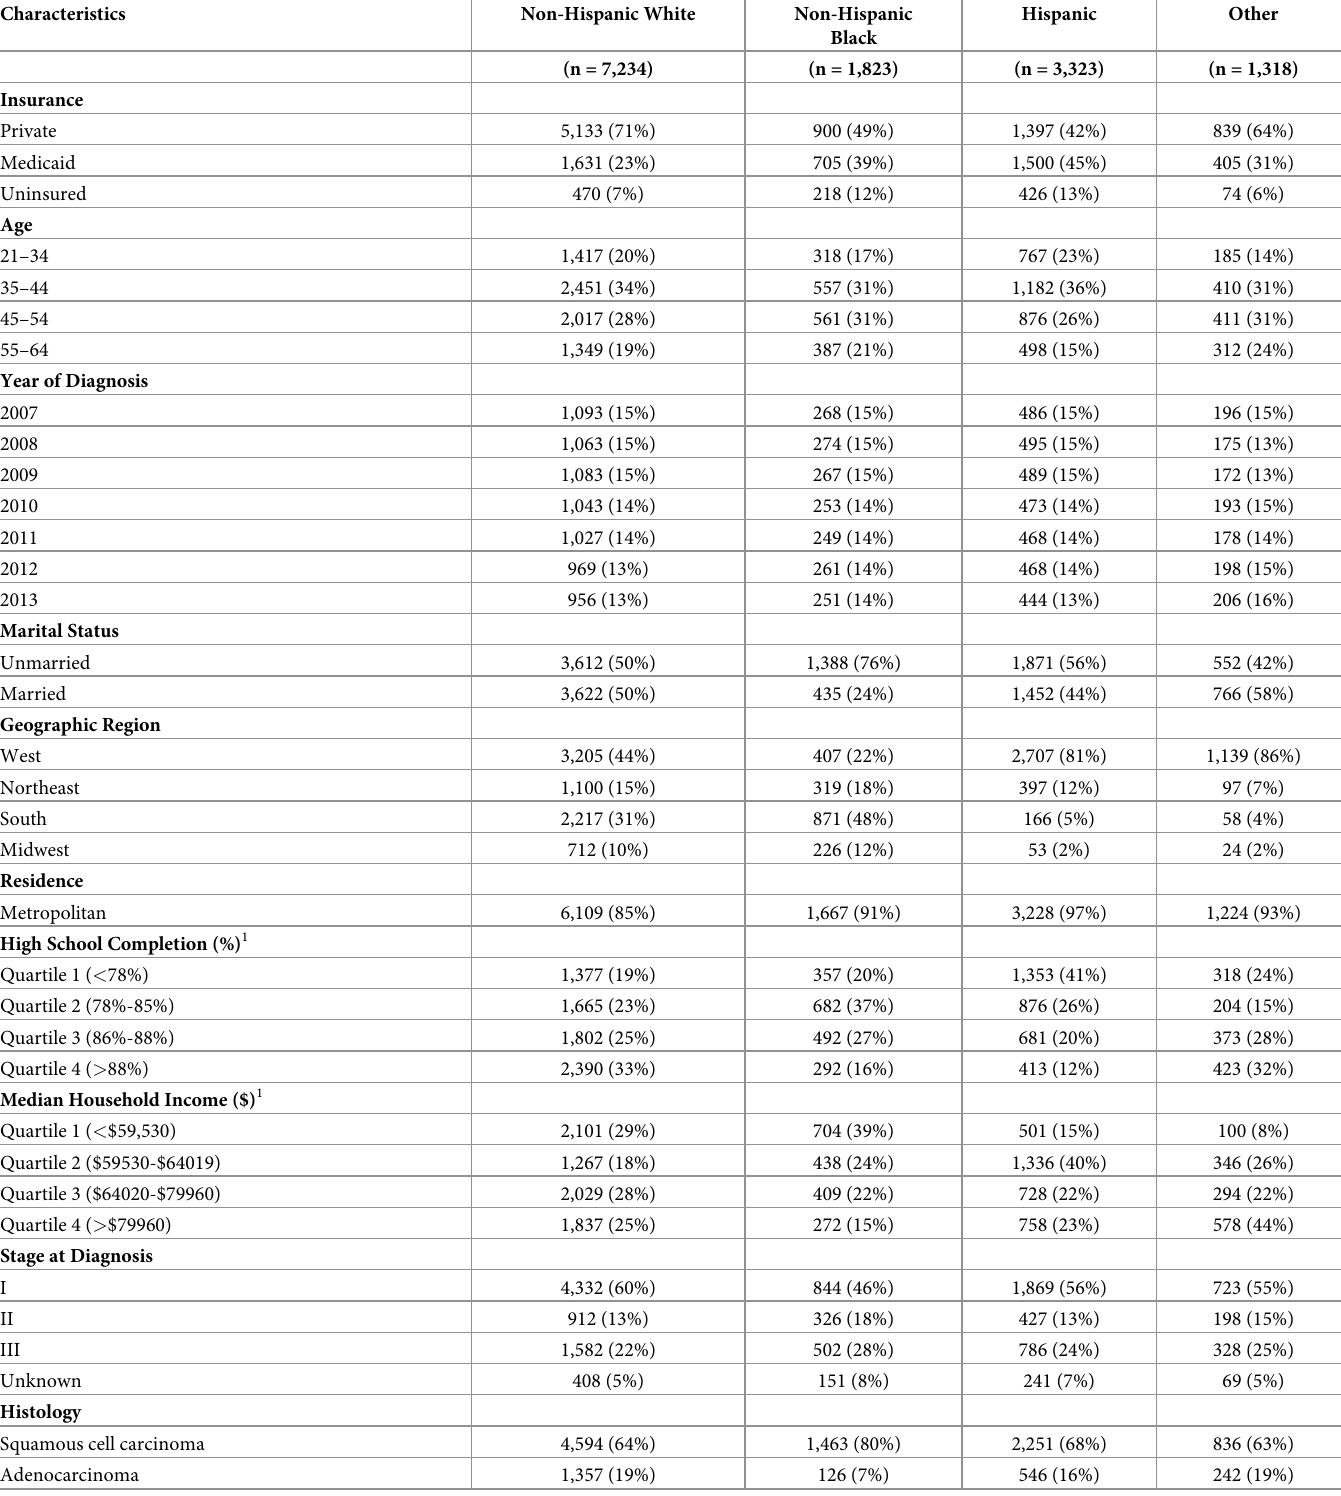
Table 1. Sociodemographic and clinical characteristics by race of women with cervical cancer in SEER, 2007–2013.